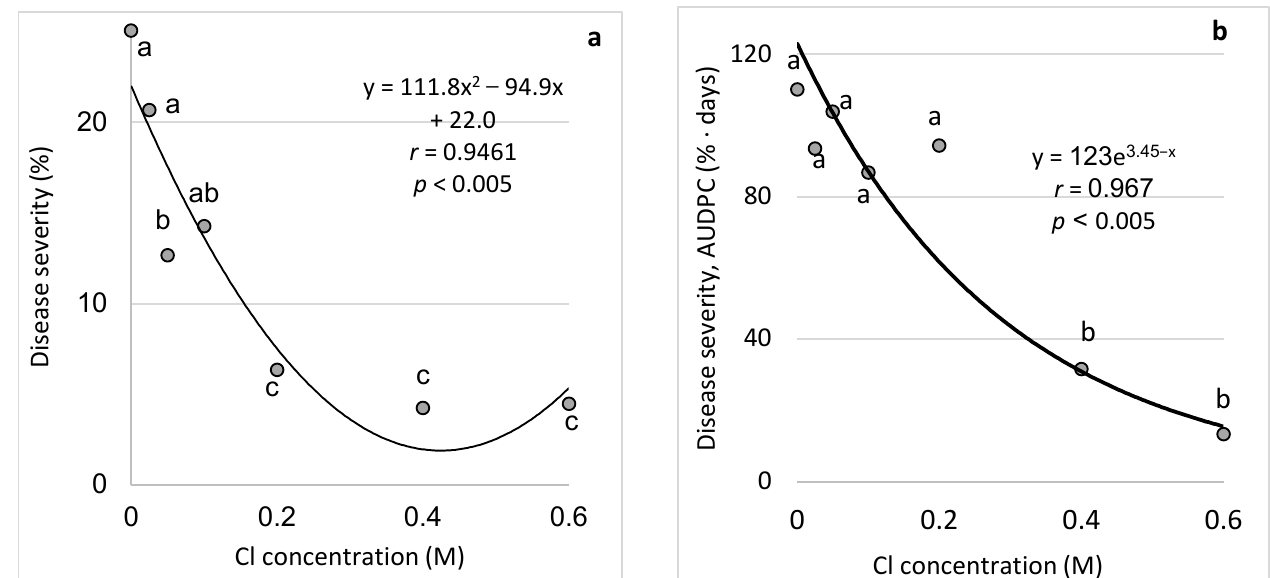
Figure 7. Effect of chloride ion concentration in the spraying solution on the severity of cucumber downy mildew (CDM, Pseudoperonospora cubensis ) on leaves of cucumber plants. NaCl was applied as spray twice a week. CDM severity was evaluated on a 0 to 100% scale, where 0% = no disease symptoms and 100% = leaf fully covered by CDM symptoms ( a ). The area under the disease progress curve (AUDPC) was calculated ( b ). In each graph, values followed by a common letter are significantly not different from each other according to Tukey-Kramer’s HSD test ( p ≤ 0.05). The regression formulas of the drawn trend lines are presented, and the correlation Pearson regression values ( r ) are presented along with significance levels ( p ).